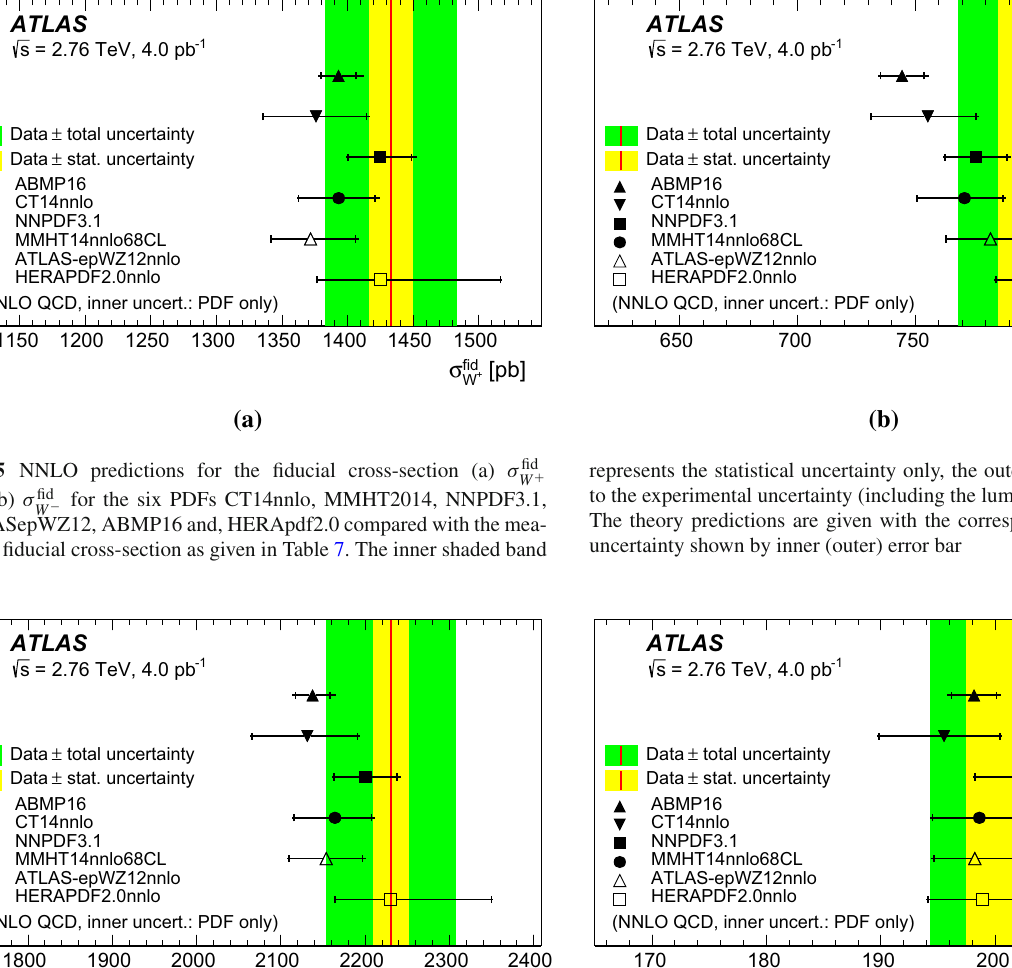
represents the statistical uncertainty only, the outer band corresponds W to the experimental uncertainty (including the luminosity uncertainty). The theory predictions are given with the corresponding PDF (total) uncertainty shown by inner (outer) error bar